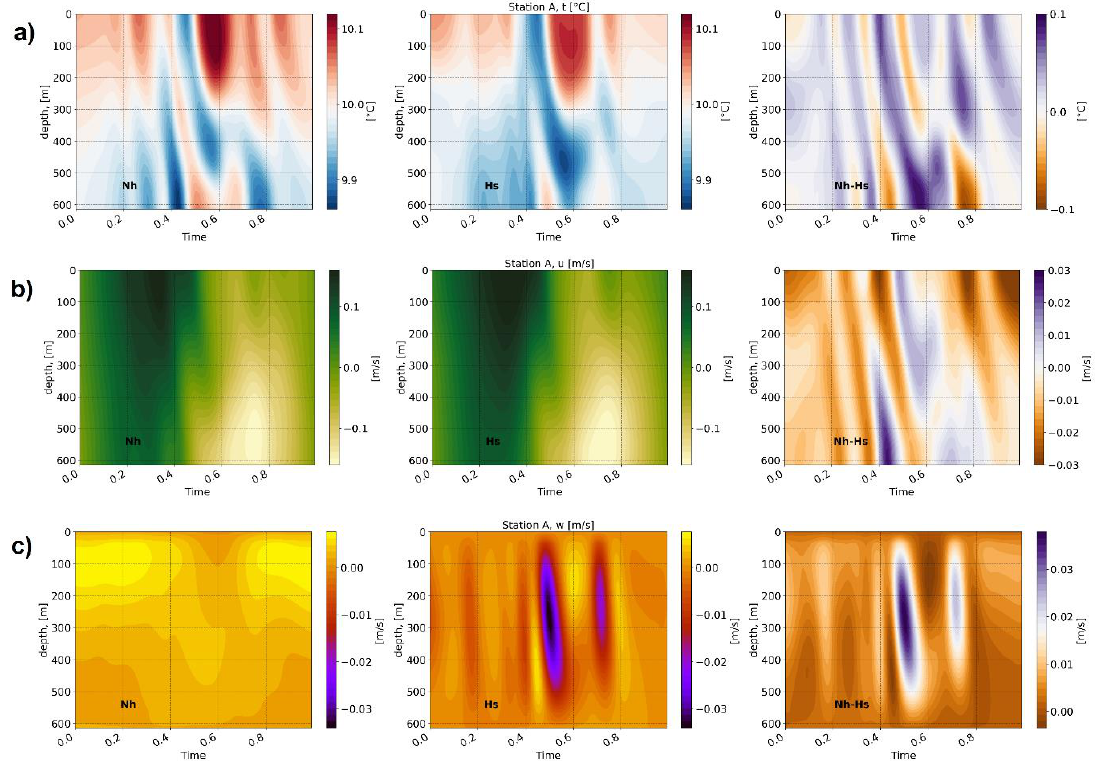
Figure 7. Hydrodynamic characteristics in point A (see Figure 2a) for the tidal period of the M 2 wave. ( a ) temperature; ( b ) cross-section velocity; ( c ) vertical velocity. Left column: Nh approach; middle column: Hs approach; right column: difference between Nh and Hs .